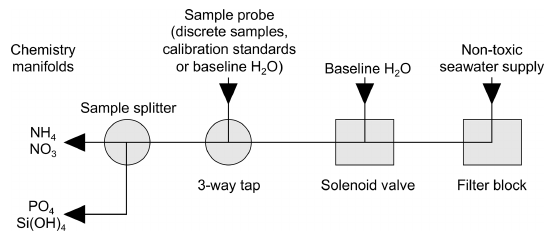
Figure 3. Sample handling schematic for flow of samples, stan- dards and baseline blanks between the ship’s non-toxic seawater supply and the chemistry manifolds of the segmented-flow analyser.